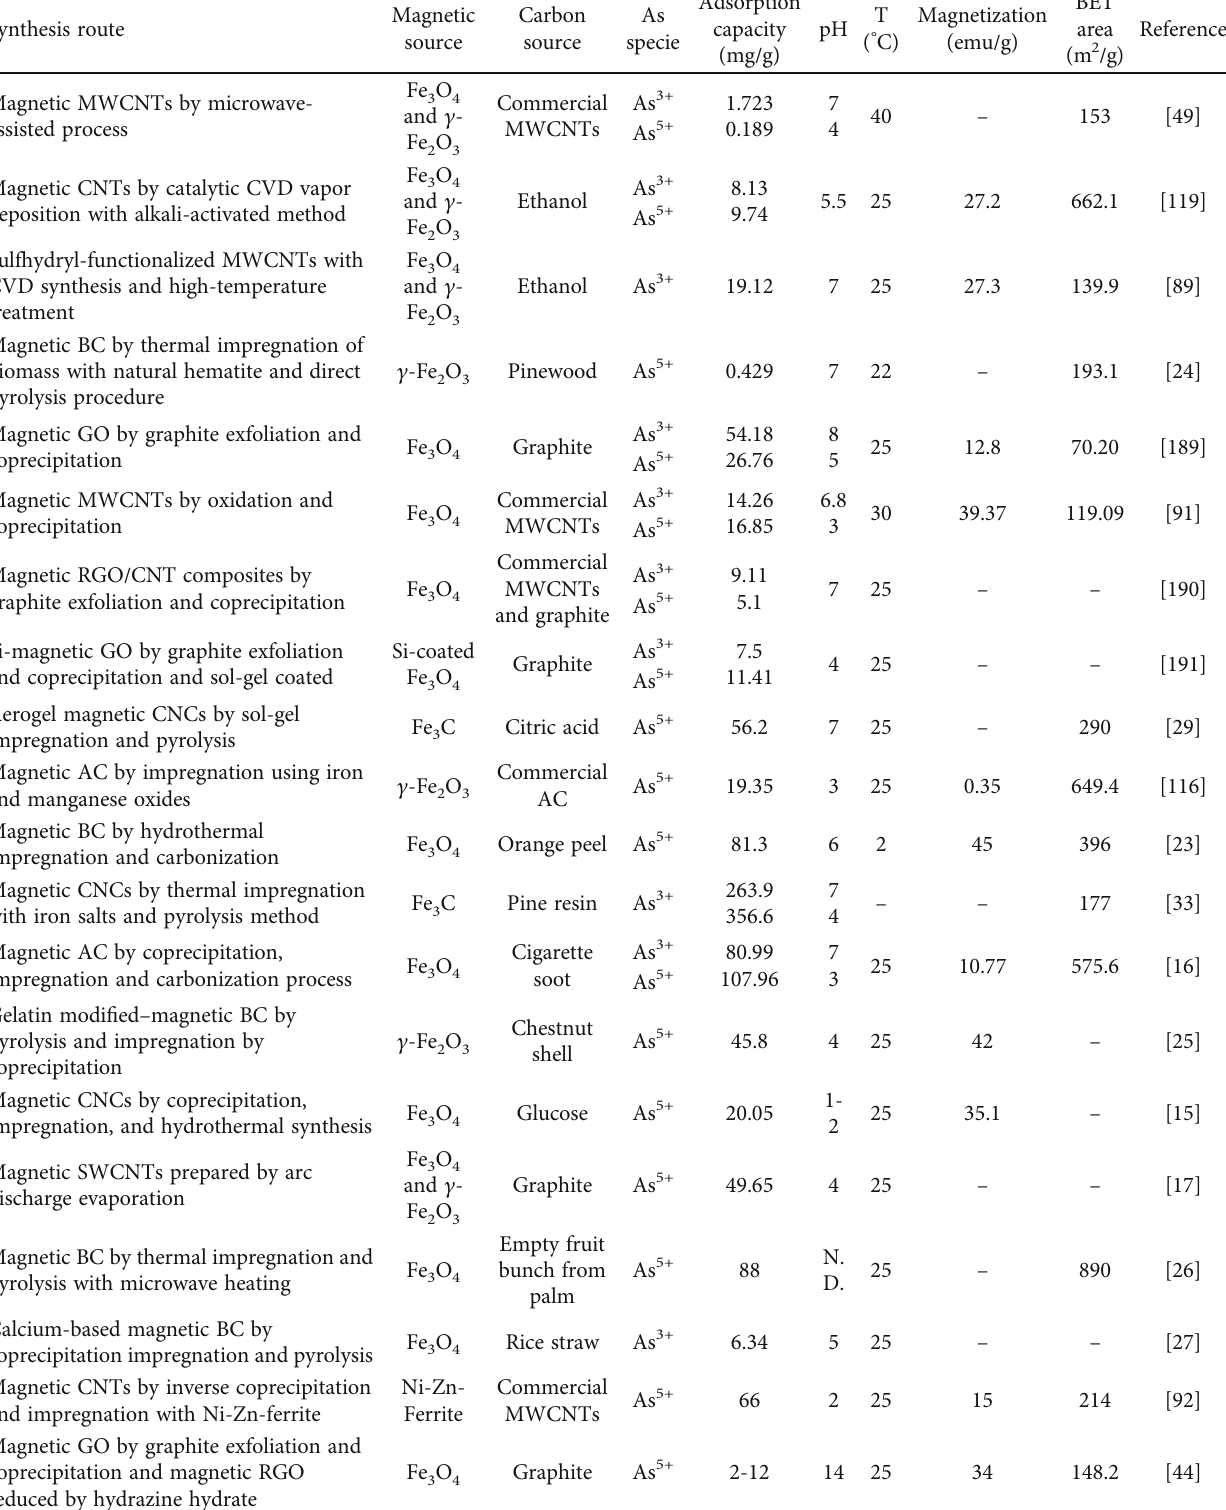
Table 1: Removal of arsenic from aqueous solution using magnetic carbon-based adsorbents: preparation, removal operating conditions, and adsorption